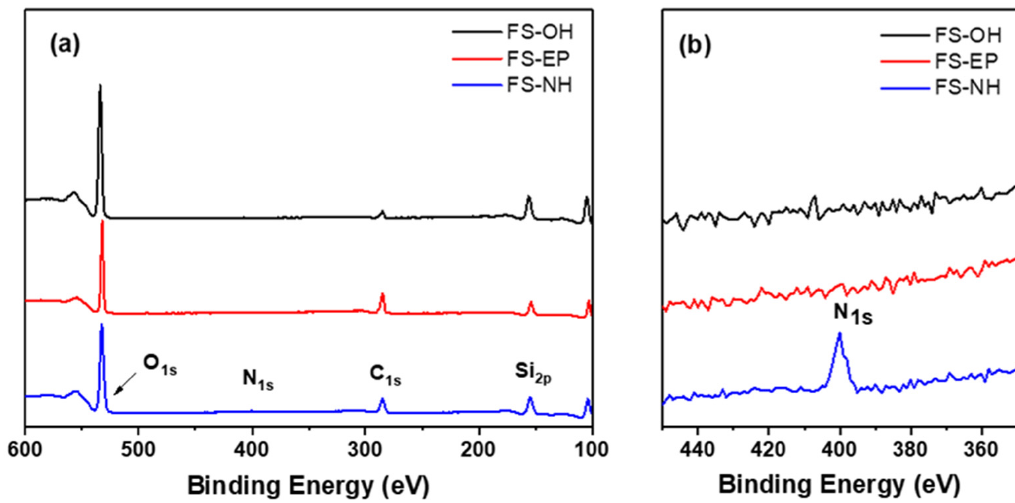
Figure 3. X-ray photoelectron spectroscopy (XPS) spectra ( a ) and N1s peak ( b ) of pristine, 3-Glycidyloxypropyl trimethoxysilane (GPS)- and 3-aminopropyl trimethoxysilane (APS)-modified silica nanoparticles.